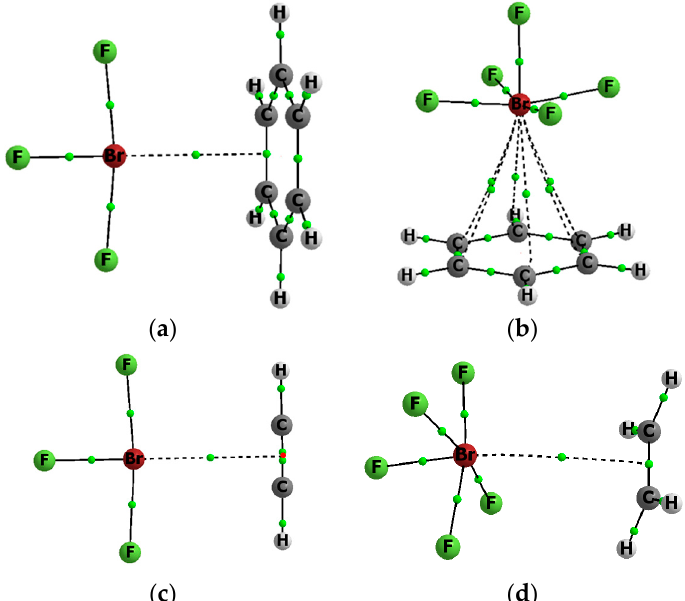
Figure 1. The molecular graphs of the following complexes; ( a ) BrF 3 -C 6 H 6 ; ( b ) BrF 5 –C 6 H 6 ; ( c ) BrF 3 – C 2 H 2 ; and, ( d ) BrF 5 –C 2 H 4 ; big circles—attractors, small green circles—BCPs, for the BrF 3 –C 2 H 2 complex ( c ), the NNA is located (small red circle) between two